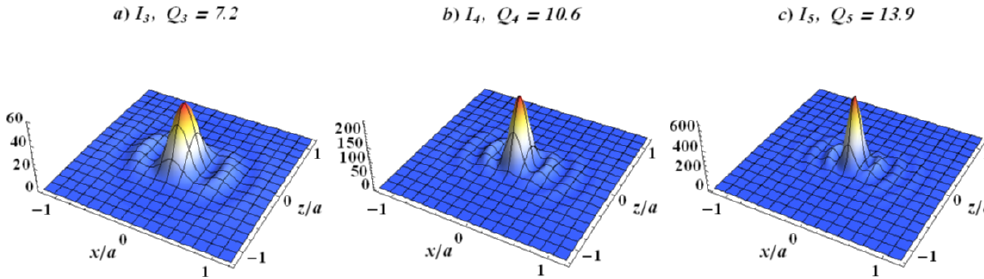
Figure 6. Electric field distribution I m = | E / E 0 | 2 and Q m factor for a ceria ( CeO 2 ) spherical particle ( a = 400nm). ( a ) m = 3, λ 3 = 716nm; ( b ) m = 4, λ 4 = 507nm; ( c ) m = 5, λ 5 = 393nm. All the parameters are available in [16], reprinted with permission from [16], the Optical Society